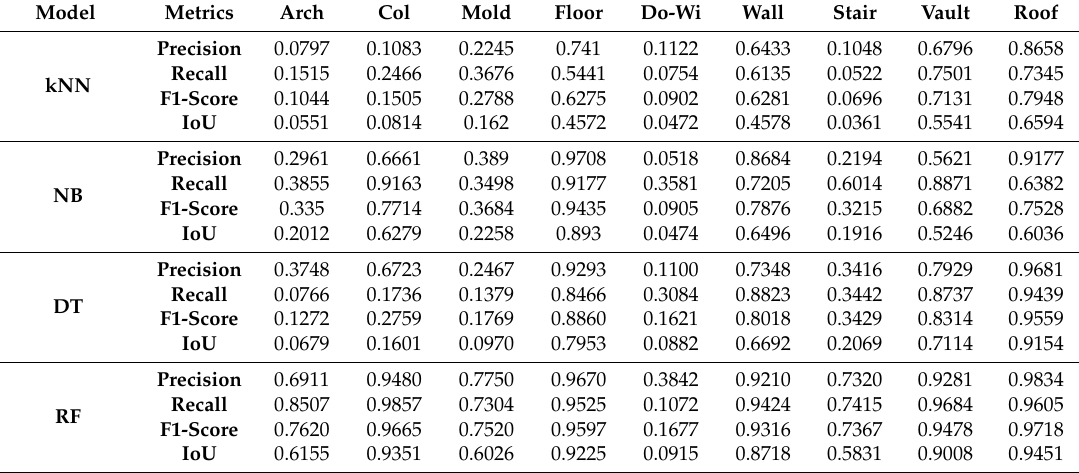
Table A3. Tests performed on the SMG scene. For the DL approach 10 scenes as training, 1 for validation (5_SMV_chapel_1) and 1 for